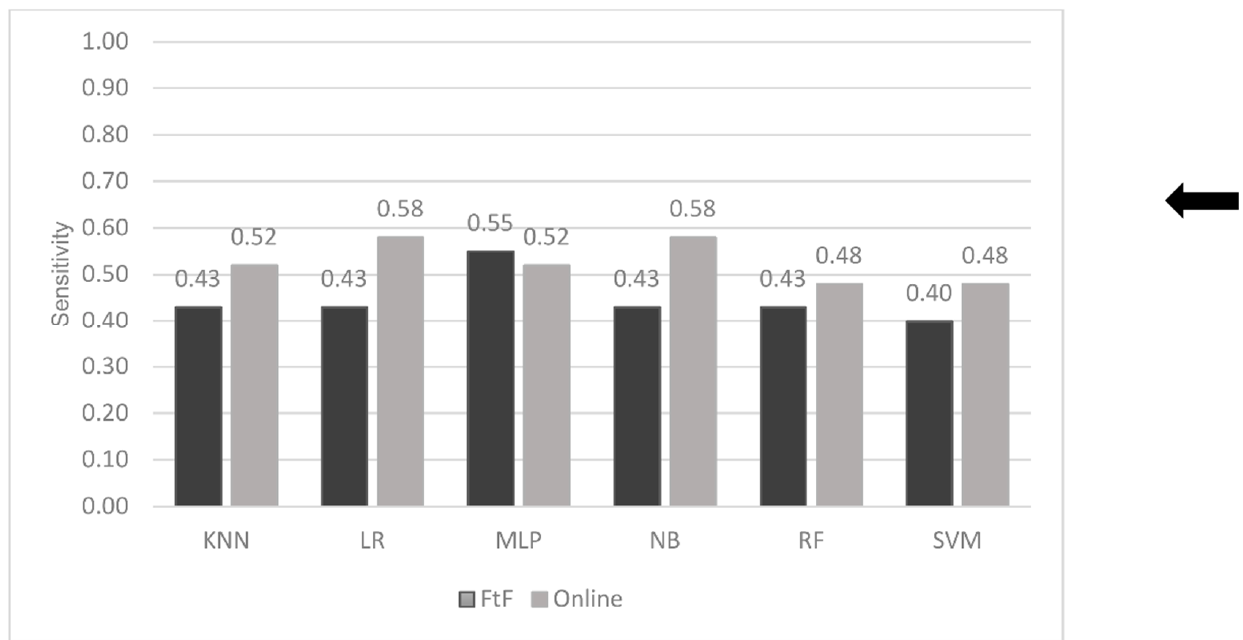
Figure 6. STA course: prediction of at ‐ risk students (sensitivity scores) by instructional mode.